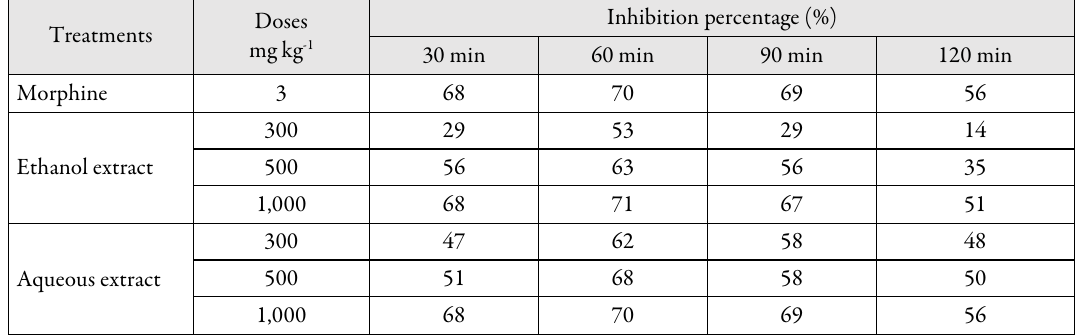
Table 2. Pain inhibition percentage for different treatment types in the tail flick